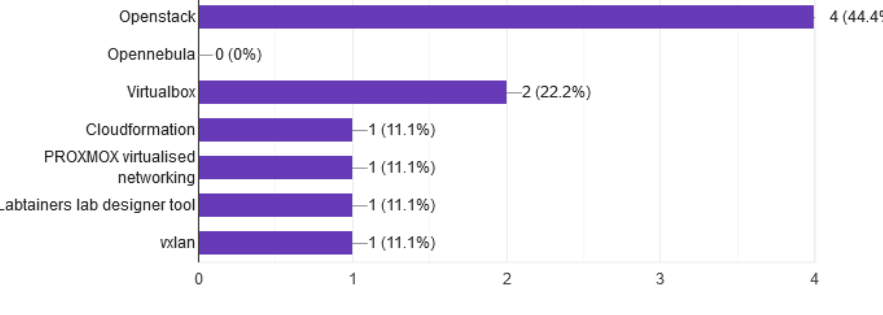
Figure 10. Network topology.